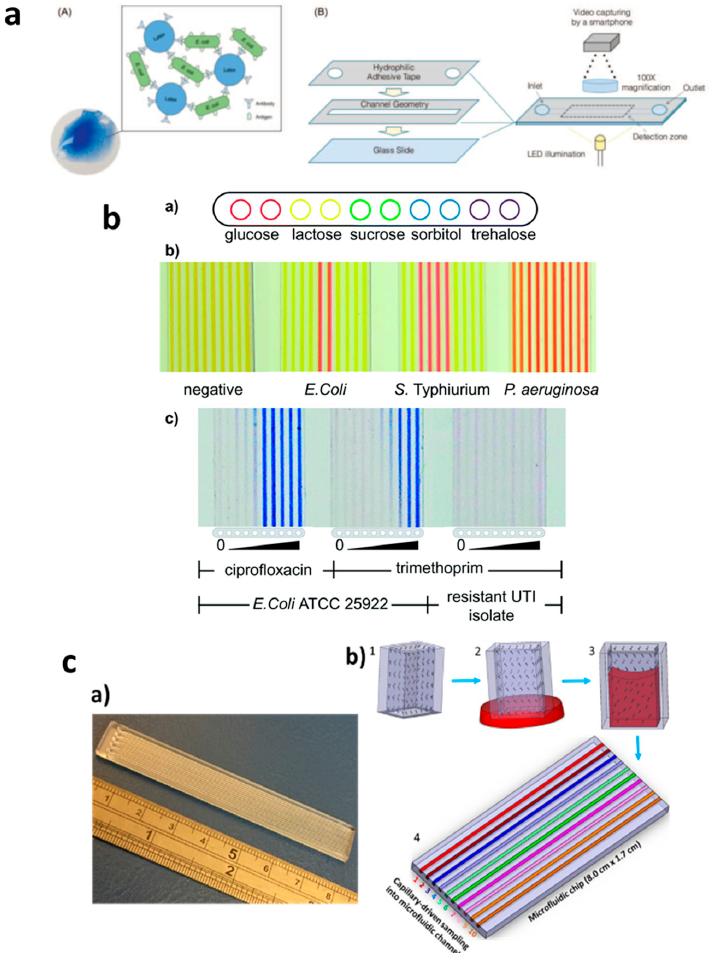
Figure 3. Applications of capillary-driven flow microfluidics for tackling antimicrobial resistance (AMR). ( a ) Immobilization of antibodies via latex agglutination test in which latex particles agglutinate upon the binding of the antibody with antigens loaded into the microchannel with the capillary flow ( A , B ). Reproduced with permission from [64]; ( b ) Fluoropolymer microcapillary-based identification of bacterial samples and antimicrobial susceptibility testing ( a – c ). Reproduced with permission from [16]; ( c ) Chip-and-dip capillary flow device fabrication and working schematic for beta-lactamase activity testing in microchannels ( a , b ). Reproduced with permission from [66].